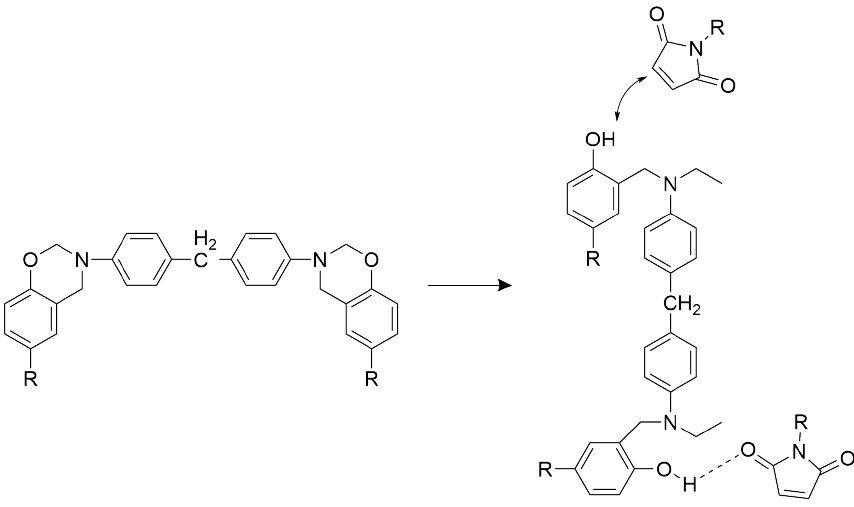
Figure 3. Possible chemical reactions between benzoxazine and bismaleimide resin [22].